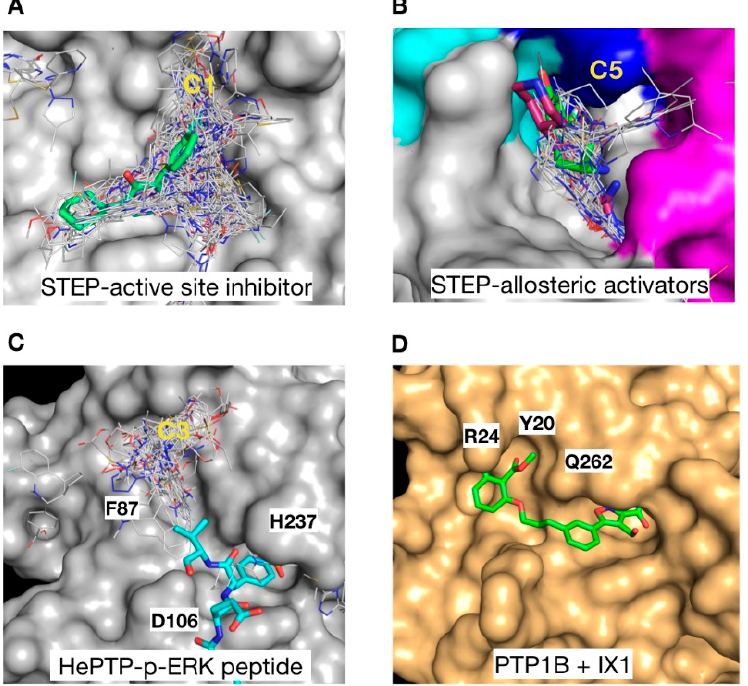
Figure 7. Functional correlation with cluster distribution. ( A ) Surface representation of STEP with C1 cluster (grey lines) overlaid onto a STEP active site inhibitor (green sticks) [18]. ( B ) STEP C5 cluster (grey lines) overlaid onto a STEP allosteric activator (magenta sticks) [19]. The STEP surface is coloured as follows: K5 in magenta, K6 in cyan, and K7 in blue. ( C ) Structure of HePTP with C3 cluster (grey lines) shown together with the HePTP substrate p-ERK (cyan sticks) [37]. ( D ) Structure of PTP1B as a gold surface in complex with the bi-dentate inhibitor IX1 (green sticks) [41]. Key residues in the secondary p-Tyr binding site are labelled.